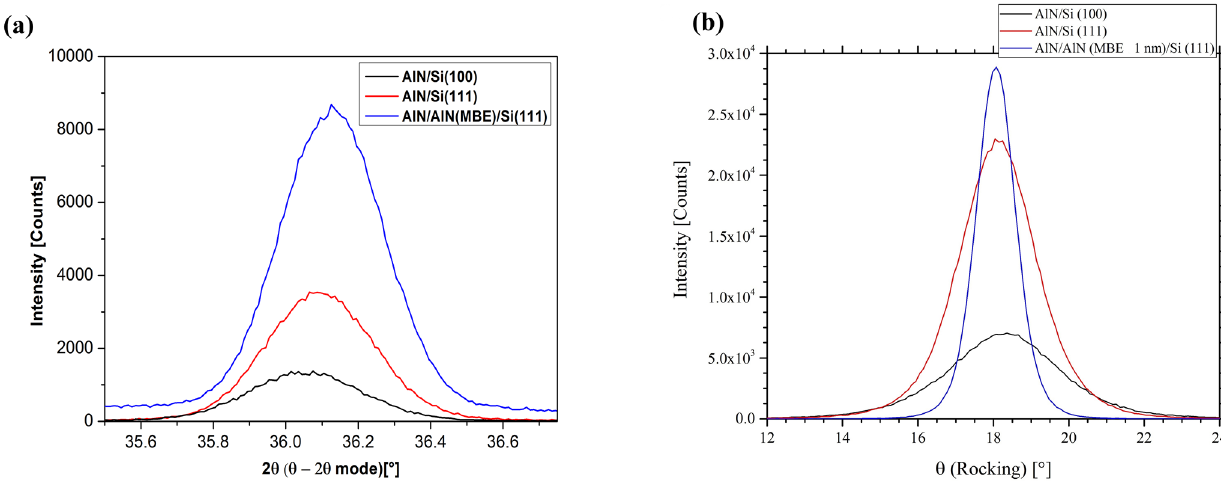
Figure 2. Diffractogram in the ( a ) θ -2 θ mode and in the ( b ) θ - θ mode showing the AlN peak of (0002) orientation for the three samples.